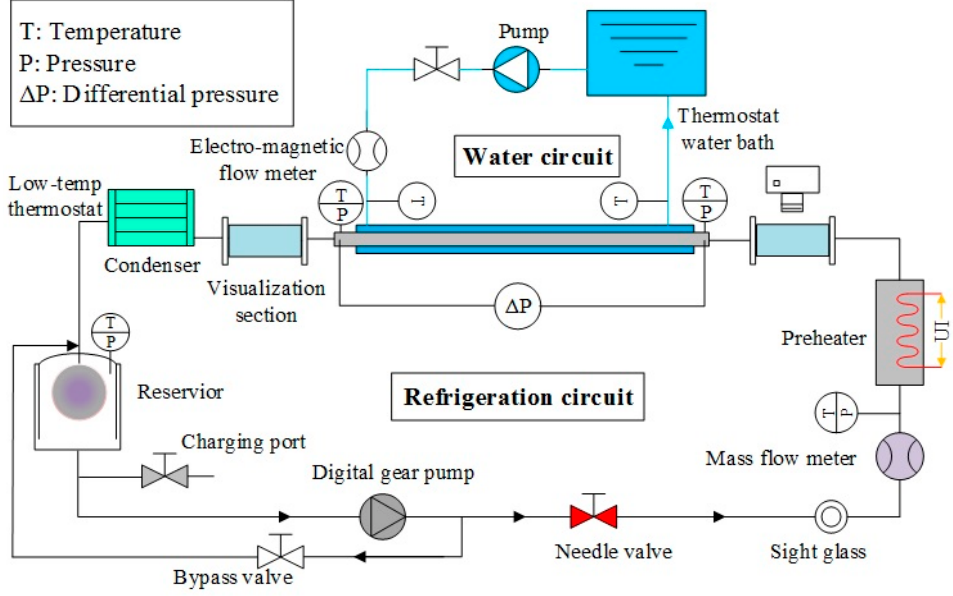
Figure 1. Experimental setup used in this study. Table 1. Physical parameters of tubes evaluated in this